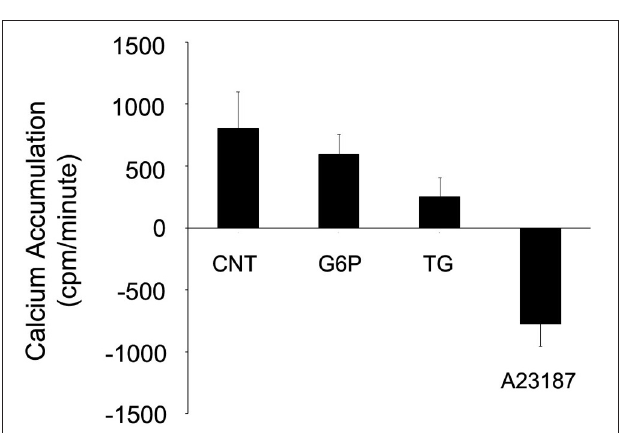
FIGURE 7 | Neither glucose-6-phosphate nor thapsigargin cause release of 45 Ca 2 + from rat brain ER microsomes. After pre-loading ER microsomes with radiotracer 45 Ca 2 + uptake for 45min, glucose-6-phosphate (10mM), thapsigargin (1 µ M), or the calcium ionophore A23187 (10 µ M) treatment was added for 15min. Only A23187 caused release of 45 Ca 2 + from the rat brain microsomes when measured by beta counter. Both glucose-6-phosphate and thapsigargin reduced the rate of accumulation, but did not cause release. Data are means ± SEM for n =